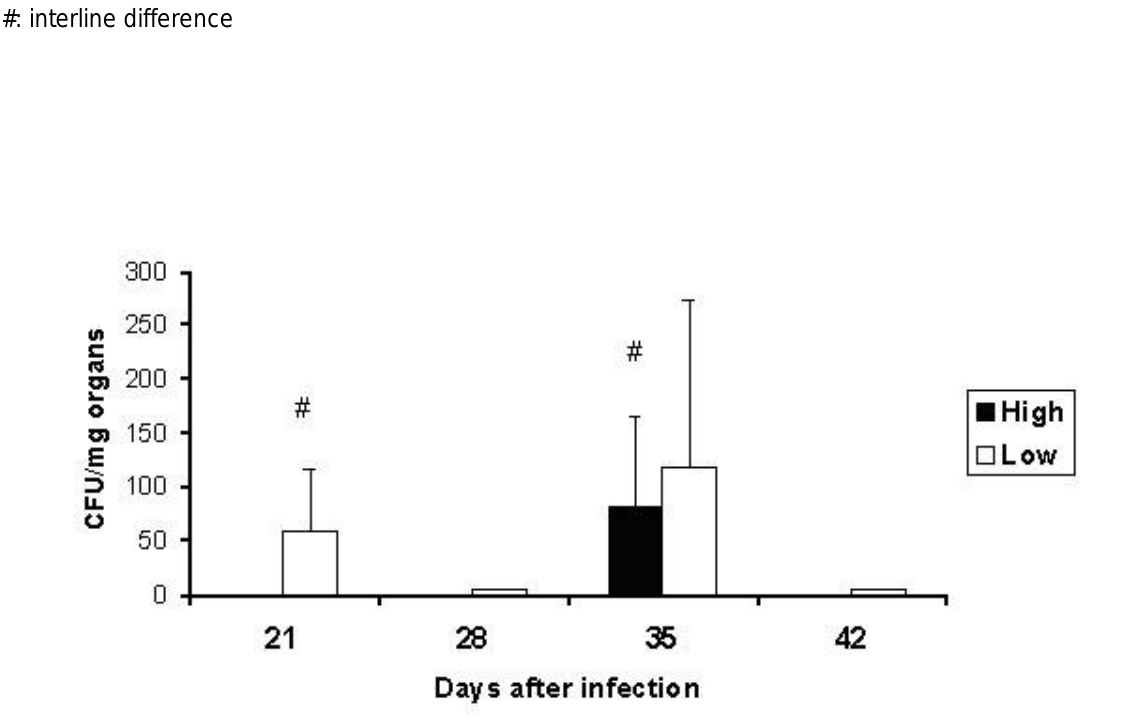
Figure 1. Recovery of viable bacteria (CFU/mg organs) from pulmonary fragments of High and Low antibody producer (Selection IV-A) mice infected with Mycobacterium . bovis -AN 5